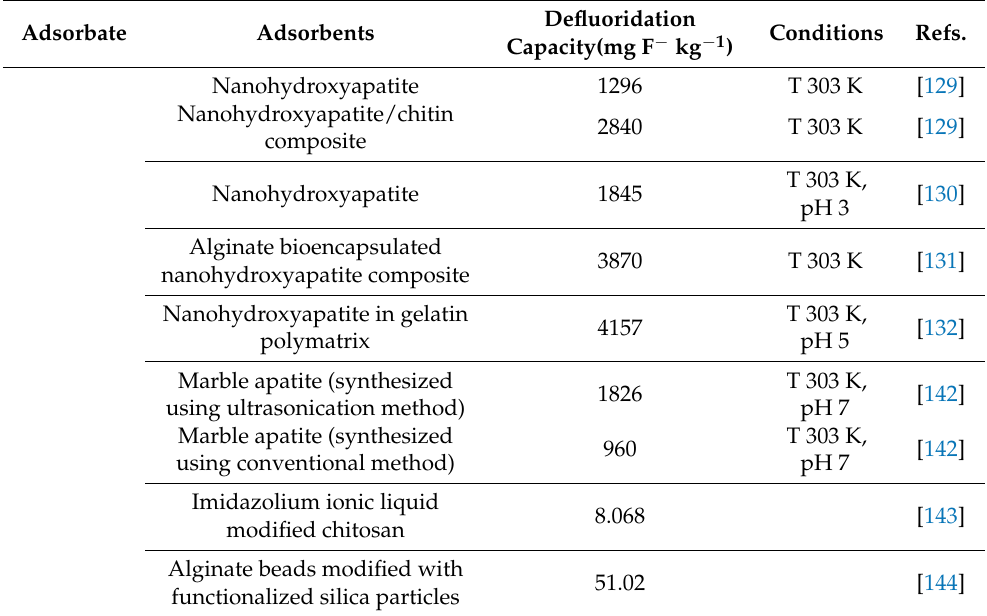
Table 4. Comparison of the adsorption capacities of nano HAp and its composites with other absorbents on fluoride